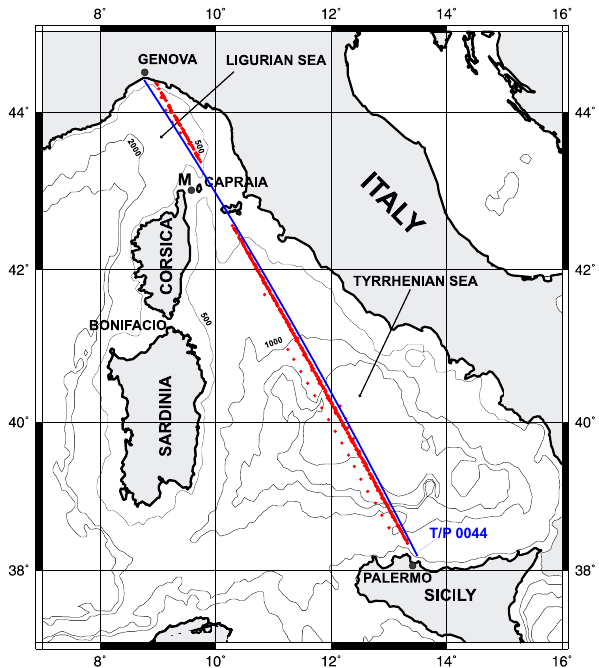
Fig. 1. Study area including bottom topography and T/P ground track 0044 with superimposed the positions of the XBTs (red dots) deployed during the VOS program as part of the